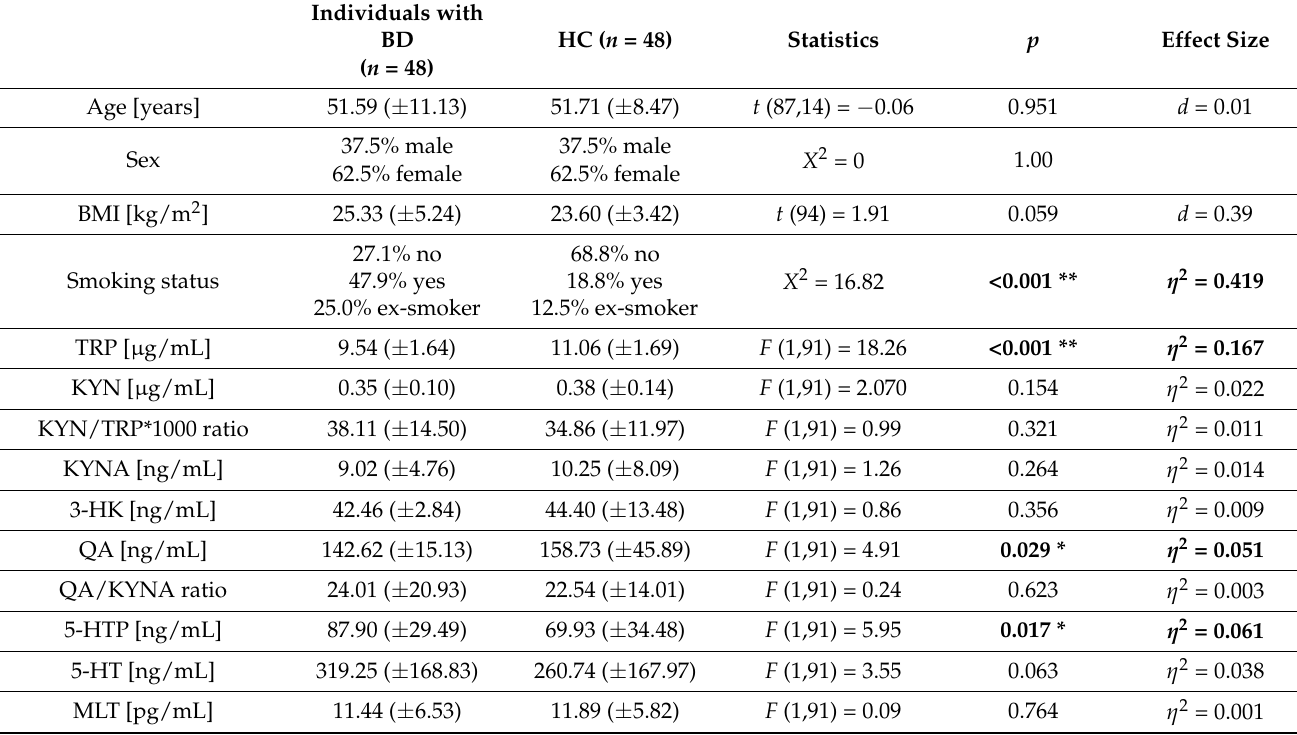
Table 1. Sociodemographic and illness-specific data of study